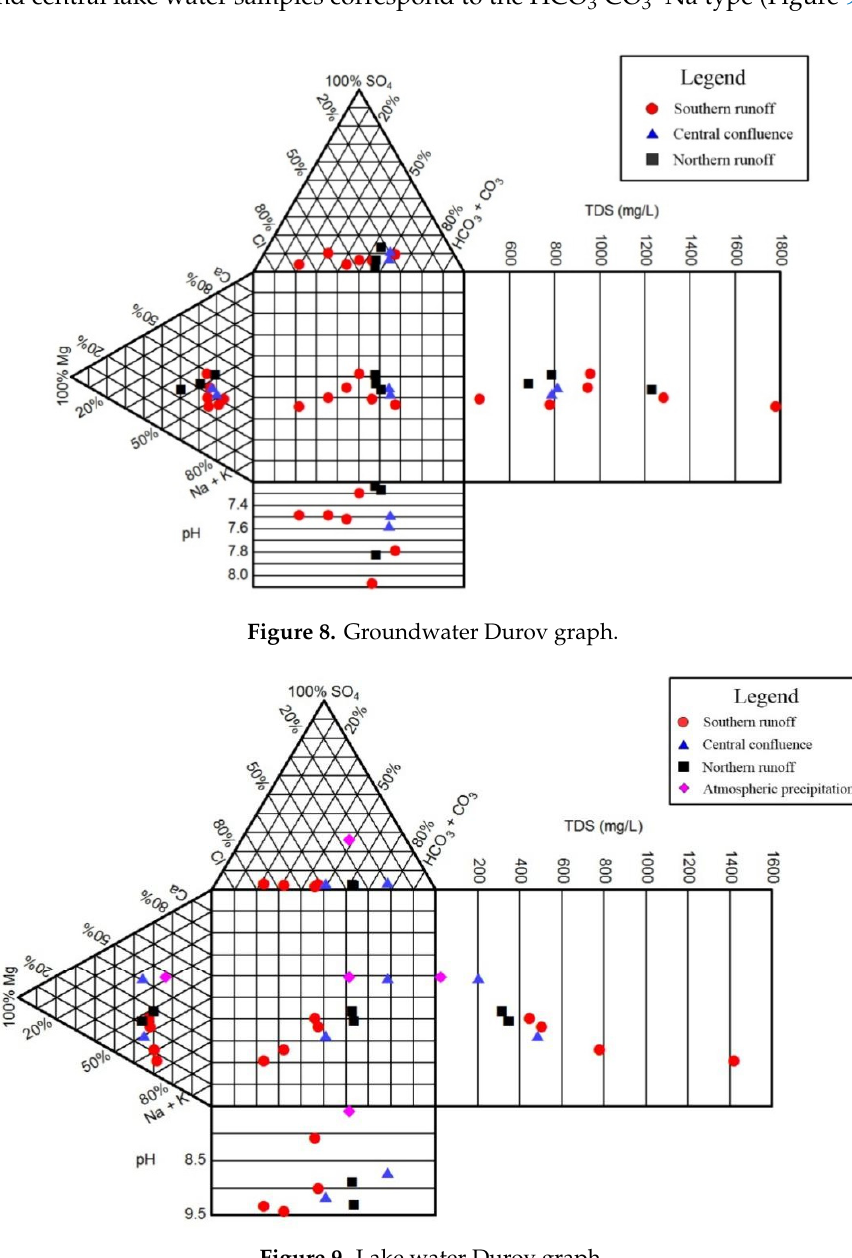
Figure 9. Lake water Durov